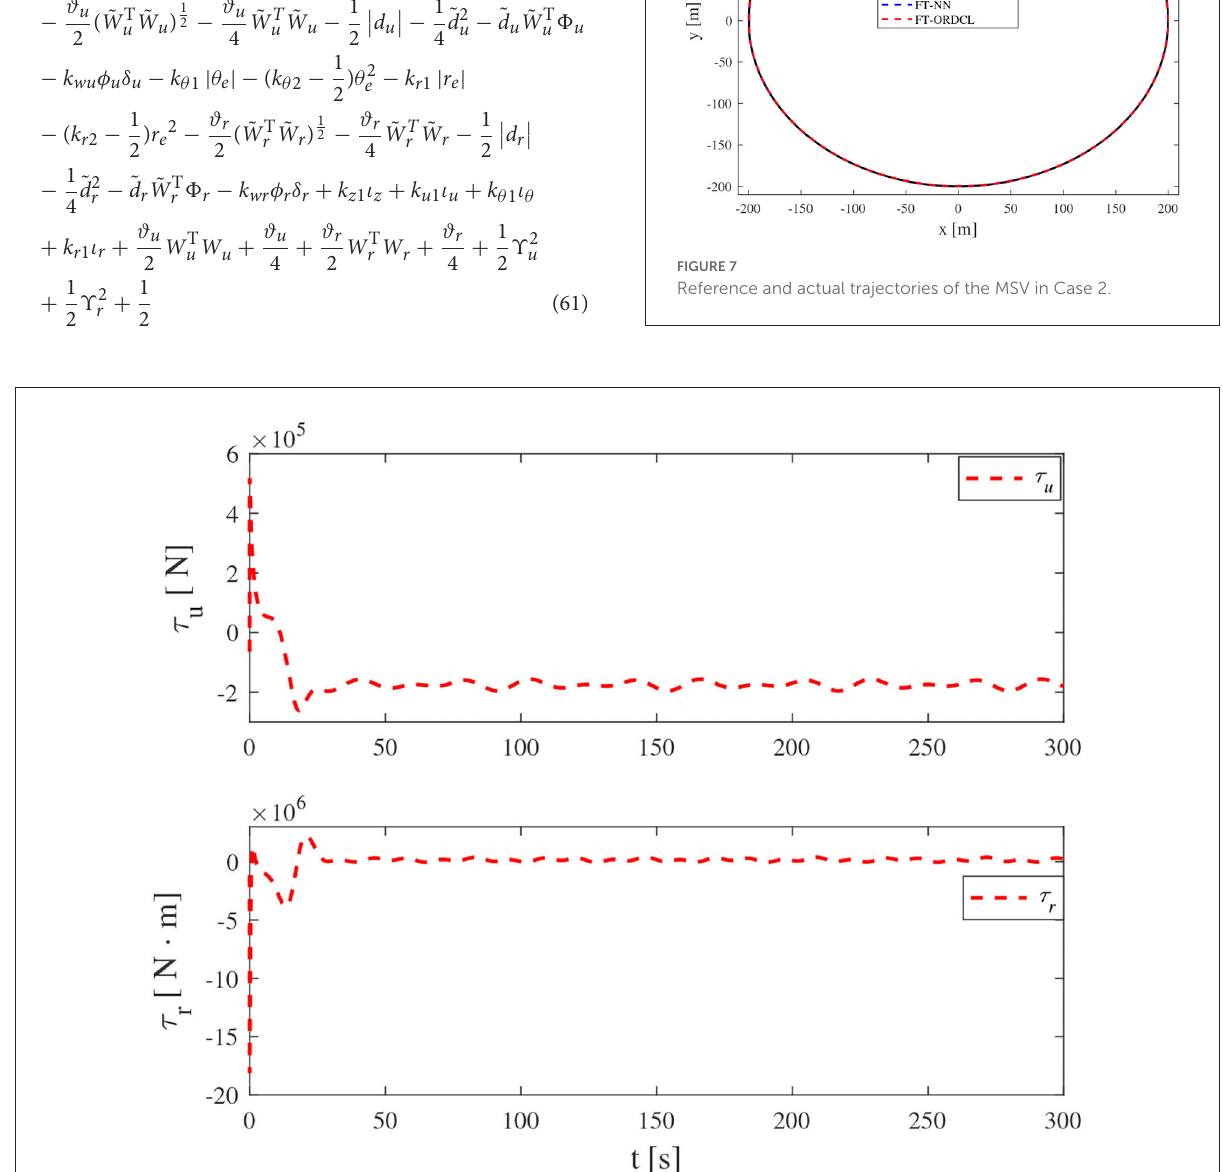
FIGURE6 Control input τ u and τ r in Case